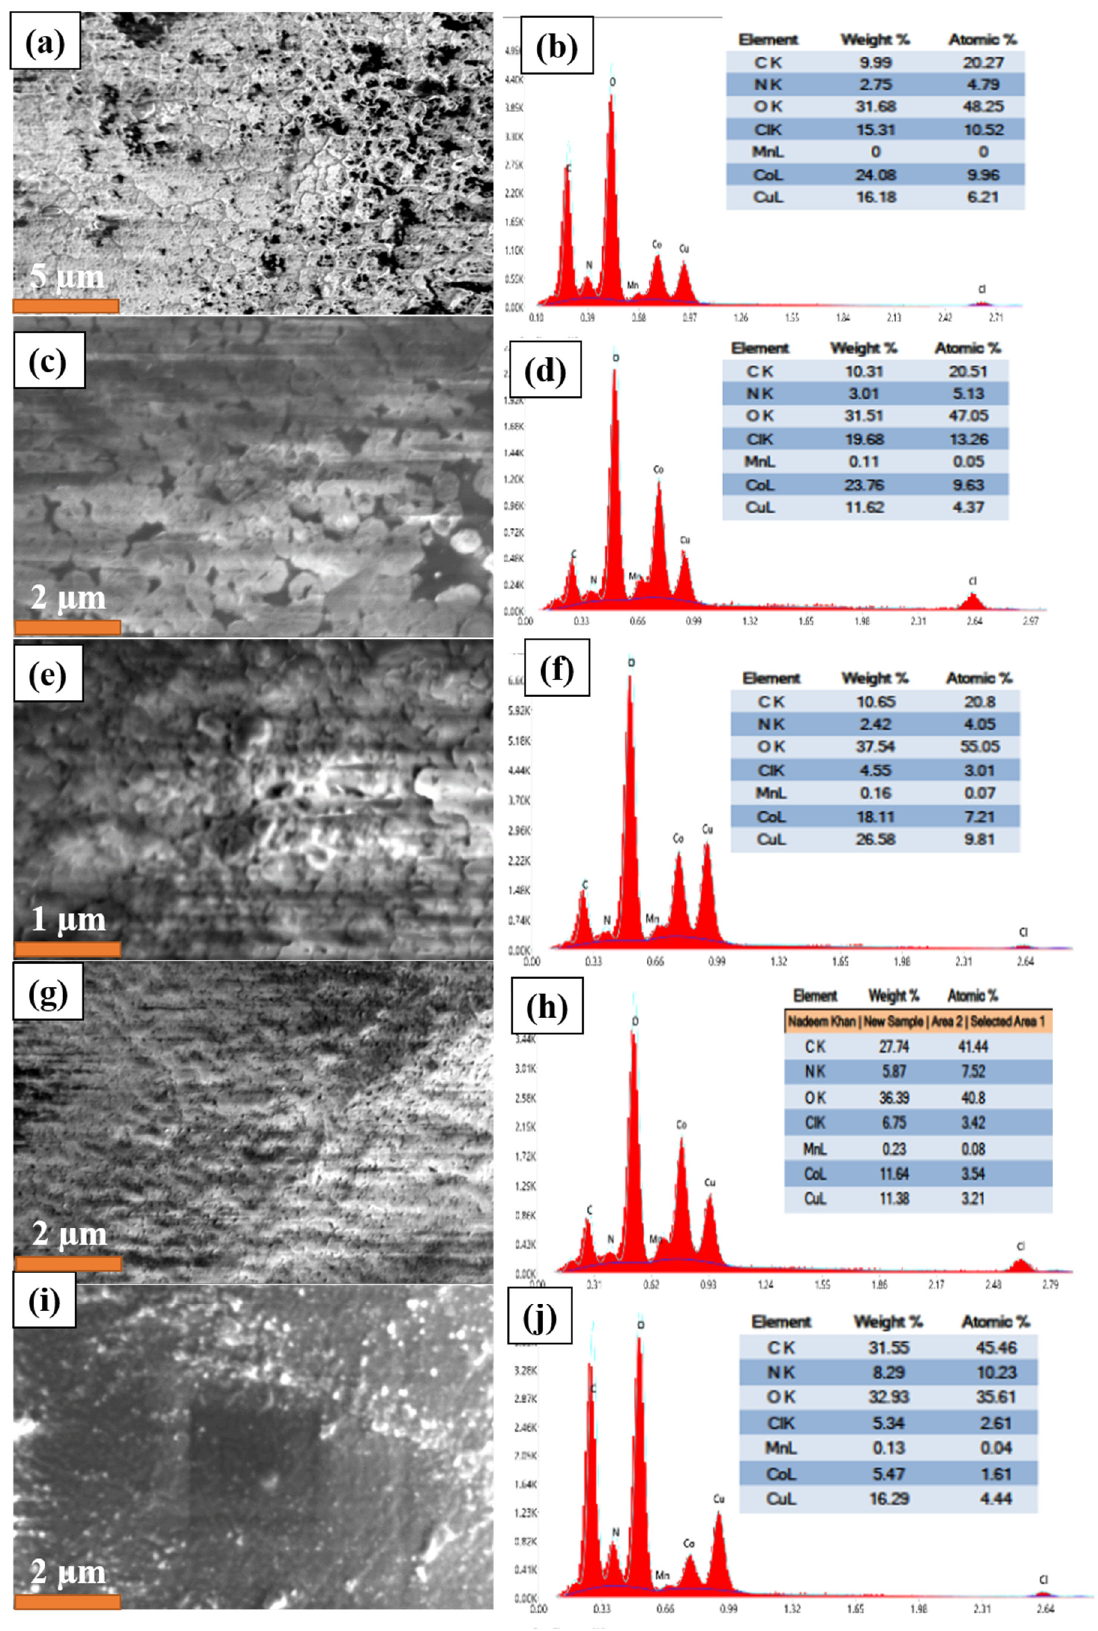
Figure 1. The FESEM and EDS images of CS@Co NPs ( a , b ), CS-AC@Co NPs ( c , d ), CS-MnO 2 @Co NPs, ( e , f ), CS-MnO 2 /AC1@Co NPs ( g , h ) and CS-MnO 2 /AC2@Co NPs ( i , j ).